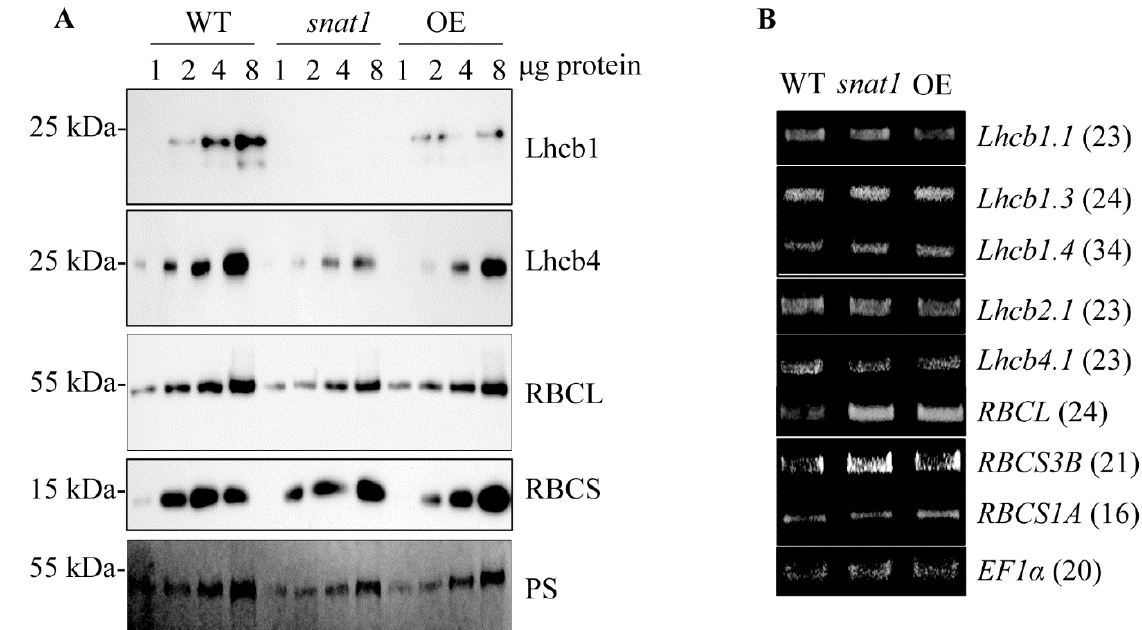
Figure 3. ( A ) Western blot analysis using anti-Lhcb1, -Lhcb4, -RBCS, and -RBCL antibodies in the WT, snat1 , and OE Arabidopsis lines at ZT8. Total leaf protein extracts (1, 2, 4, and 8 µg) were subjected to 14% SDS–PAGE. The immunoblot was probed with specific antibodies, as indicated on the right. Molecular weights are shown on the left. The bottom panel shows a loading control stained with Ponceau S solution (PS). ( B ) qRT-PCR analysis of the corresponding transcripts at ZT8. EF1α was used as a loading control. Numbers in parentheses indicate the number of PCR cycles.